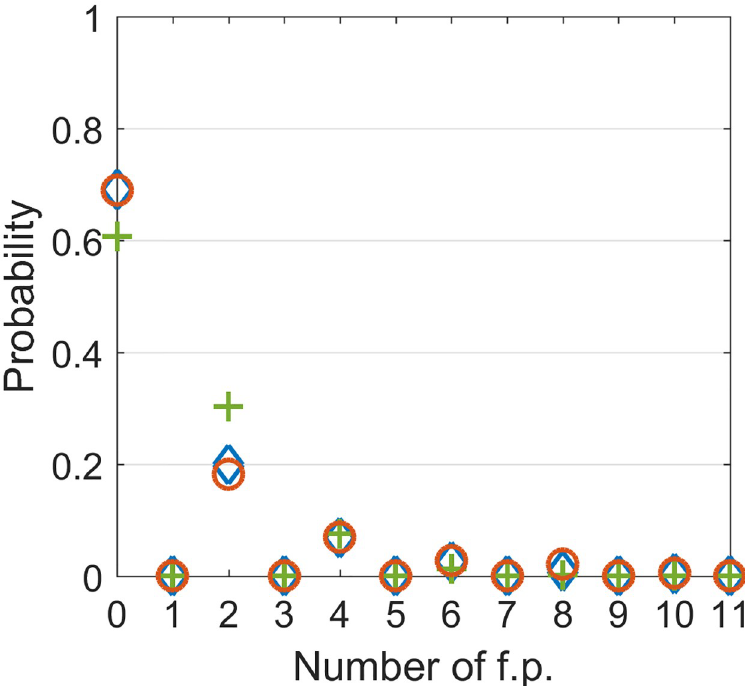
Fig 8. Probability of number of fixed points in Boolean networks. ’+’—theoretical prediction. � and � —empirical estimates for networks of size N = 16 and 19 based on 10 4 and 10 3 random network realizations respectively. https://doi.org/10.1371/journal.pcbi.1007825.g008 For intermediate values of σ the picture is more complicated. Chaos is not suppressed but h the symmetry between ± s is broken by the drive (in the open loop setting only, since once the loop is closed symmetry is restored). For σ � 1 one might repeat our reasoning for σ = 0, this h h time with single fixed points rather than pairs, and therefore with Eq (25) being replaced by: M � Poisson ð 1 Þ : ð 26 Þ Numerical observations on small networks reported in Table 1 tell us that while a sharp transi- tion in the distribution of fixed points is observed once a drive is introduced, the distribution of M does not immediately match Eq (26). Here again we tend to attribute such a discrepancy with theory to finite size effects compromising the fixed point orthogonality. Table 1. Numerical estimates for the distribution of M are shown as a function of external drive strength for an ensemble of dense random networks of size N = 16 with Gaussian i.i.d elements. Random Gaussian drive is scaled by σ . Poisson distribution with parameter l ¼ 1 ; 1 are provided for reference. h 2 σ